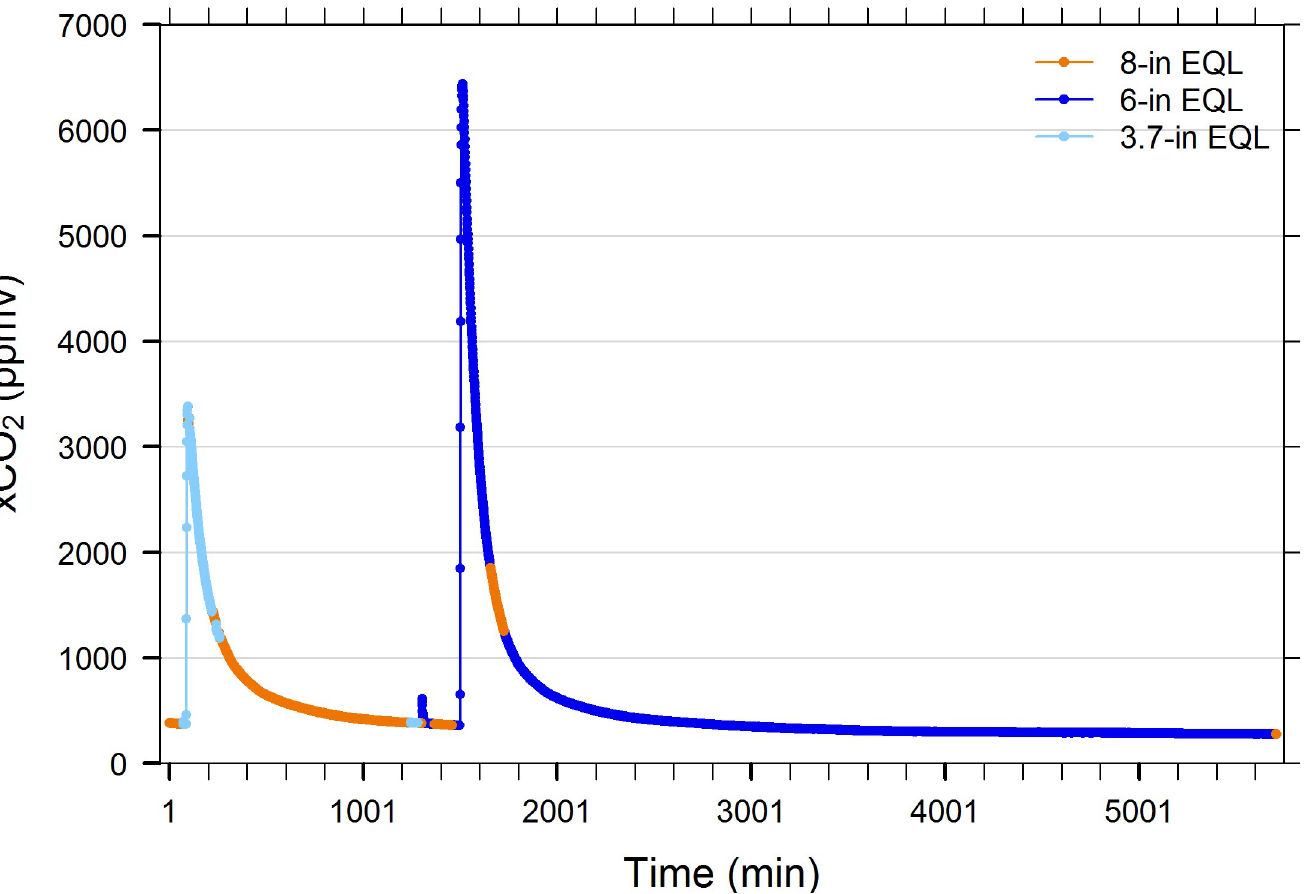
Fig 5. Performance comparison of 8-in, 3.7-in, and 6-in diameter spherical equilibrators. Common water was pumped continuously to selected pairs of EQLs throughout the 4-day period and valves connecting sample lines to air pump and IRGA circuit were switched periodically for instantaneous comparisons. Changes in slope are due to increased bubbling of test tank with CO 2 -stripped air. Tank was enriched with compressed CO 2 at minute 1500. Note: 3.7-in EQL was replaced with 6-in EQL at minute 1304, as indicated by small spike caused by brief non-equilibrium starting condition of 6-in EQL. See Table 2 for EQL